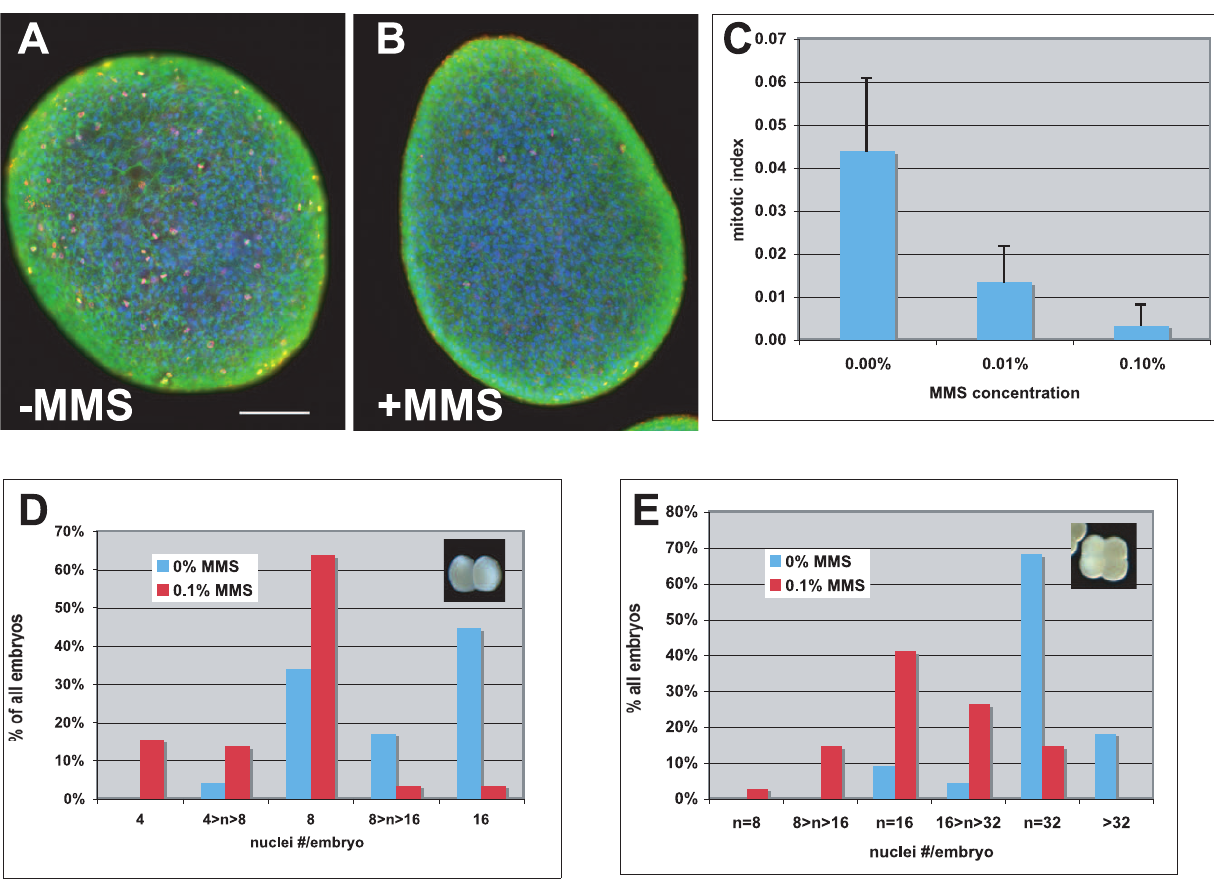
Figure 1. MMS inhibits mitosis in gastrula and cleavage stage embryos. (A, B) Gastrula stage embryos were incubated in filtered seawater (FSW) containing 0 (- MMS) or 0.1% ( + MMS) MMS for one hour before fixing and staining with antibodies to detect phospho-Histone H3 (red) and b - tubulin (green). The embryos are also stained with bisbenzamide to visualize DNA. (C) Mitotic index after 1-hour incubation in FSW containing various concentrations of MMS is quantified. The data are from 2690 cells in 11 embryos (0%), 3055 cells in 10 embryos (0.01%) and 2892 cells in 11 embryos (0.1%) in two different experiments. Error bars represent one standard deviation each. (D, E) Histograms show the percent of embryos that show nuclei number (n) per embryo as indicated when 2-cell (D) and 4-cell (E) stage embryos were incubated in 0 or 0.1% MMS in FSW for one hour, fixed and stained as in A and B. Mitotic figures from prophase to anaphase were counted as one nucleus each. Telophases (see Supplemental Figure S2) were counted as two nuclei each. Additional information on these data sets are in Table